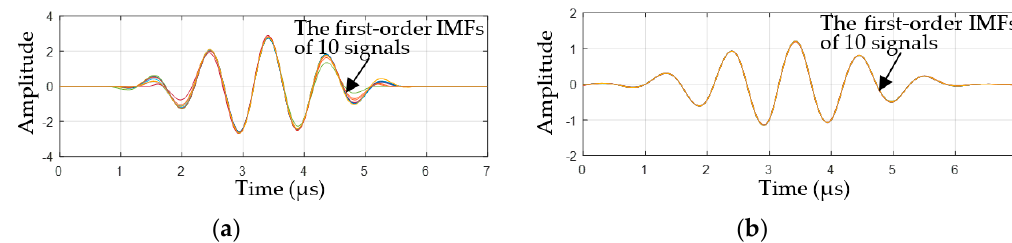
Figure 6. The first-order IMFs of two decompositions. ( a ) The first-order IMFs obtained by decomposition without zero-phase filtering; ( b ) The first-order IMFs obtained by decomposition with zero-phase